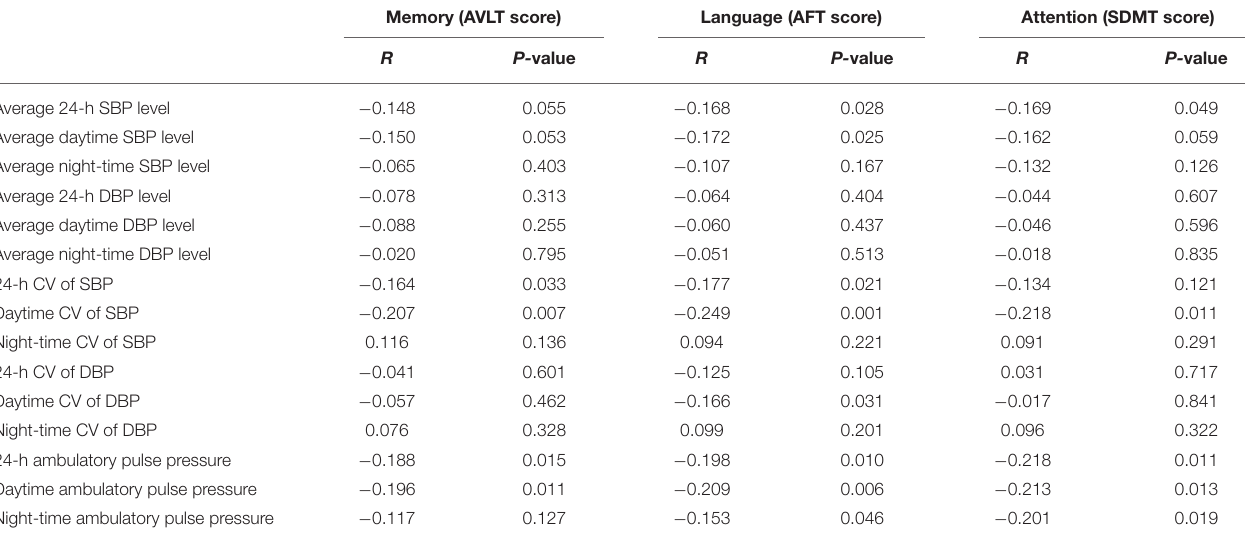
TABLE 3 | The correlation analysis between 24-h ambulatory BP variables and the scores of multiple cognitive domains in patients with AD. Memory (AVLT